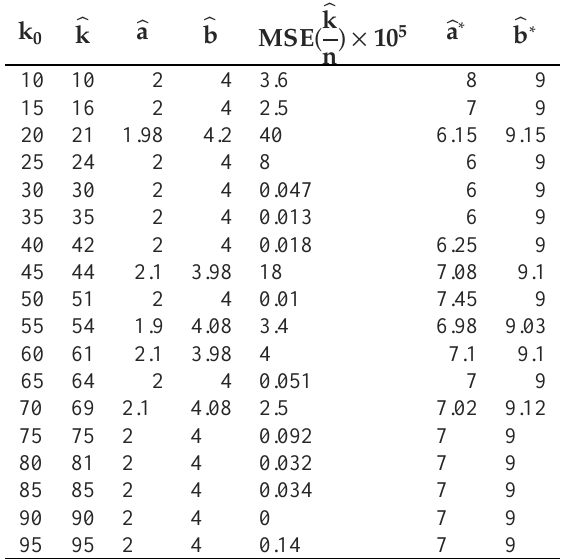
Table 1. LR results: simulation Poisson regression model.